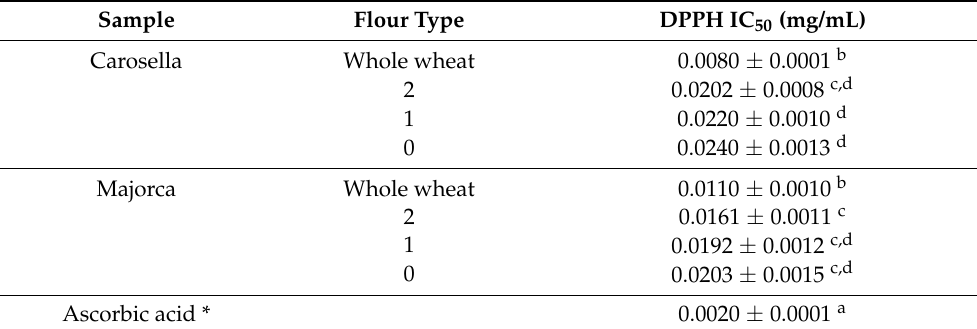
Table 4. Free radical scavenging activity of Carosella and Majorca